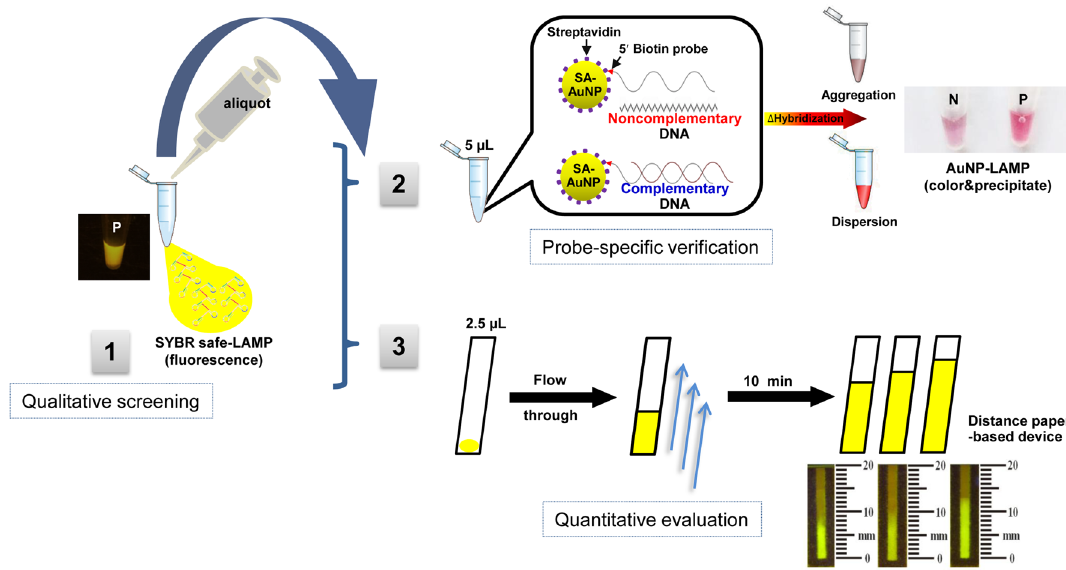
Figure 1. Schematic procedure of LAMP detection and semi-quantification using a distance-based paper device combined with one-step SYBR safe and gold-nanoparticle probe LAMP limit the boundary channel of sample and detection zones of the dPAD, the filter paper was dropped so that the LAMP reaction could flow into the detection channel zone without leakage of the flow samples. Five different patterns of dPAD were shown to immobilize the LAMP reaction at different lengths of migratory distance and could be directly measured by BL visualization. To acquire the suitable loading sample volume in the dPAD, the length difference of migratory distance between the negative and positive LAMP reactions at different parasites’ DNA concentration was evaluated. The optimization of each sample volume is shown in Fig. 2b. The samples were loaded at 0.5, 1.5 and 2.5 µL and the distance lengths of each load volume in millimeter scale (mm) were compared. The mean fluorescent distance of each concentration load volume was 1.78 ± 1.30 (mean ± SD) mm for negative control, 3.78 ± 2.11 mm for 10 5 parasites/mL and 5.11 ± 2.67 mm for 10 7 parasites/mL, respectively. The fluorescent distances were significantly differences in negative (N) and two positives (10 5 and 10 7 ) ( F = 25.85, 79.15, 130.85; P -value = 0.001, < 0.001, < 0.001, respectively). The differences of the fluorescent migratory dis- tance between positive and negative results at 0.5, 1.5 and 2.5 µL were 1.00, 2.00 and 3.00 mm with RSD values as 0.00 ( n = 3), 0.00 ( n = 3) and 0.00 ( n = 3), respectively for 10 5 parasites/mL, and 1.67, 3.34 and 5.00 mm with RSD values as 0.35 ( n = 3), 1.73 ( n = 3) and 0.20 ( n = 3), respectively for 10 7 parasites/mL. According to the difference of the flow results, the load volume at 2.5 µL demonstrated the longest immobilized length of fluorescent migra- tory distance on the filter paper as the best migratory distance. Of these, 2.5 µL which gained the highest fluo- rescent length of reaction flow distance were chosen as a standard load volume for all five patterns of the dPAD. All five patterns of the designed dPADs could differentiate between negative (N) and positive samples (10 5 and 10 7 ) (Fig. 3). The migratory distances were significantly differences in patterns 1 to 5 ( F = 7.84, 5.69, 11.44, 9.60, 30.41; P -value = 0.026, 0.048, 0.012, 0.017, < 0.001, respectively). The distances of Leishmania ’ DNA con- centration at 10 5 and 10 7 parasites/mL were similar to patterns 1 to 4. The differences ranged between 1.67 to 2.00 mm depending on the patterns of the devices (Fig. 3a). However, the highest difference at 3.67 mm was observed in pattern 5 between 10 5 and 10 7 parasites/mL (Fig. 3b) that constituted a simple straight pattern in which the LAMP reaction was loaded in the sample channel zone at the bottom of the device and flowed into the detection channel directly straight forward. Thus, pattern 5 was chosen to gain the optimal migratory distance. These were further used to calibrate a device using a linearity between the fluorescent distance and the standard concentrations of Leishmania ’ DNA, then for quantitative measurement of the LAMP products. Semi‑quantitative analysis and specificity. curve and linear range (Fig. 4). The results of serial dilution showed concordance of detection between the visual inspection of fluorescent dPAD (Fig. 4a) and colorimetric precipitate AuNPs probe, as well as gel electrophoresis (Fig. 4b). Gel electrophoresis exhibited various multiple bands of stem-loop DNA structures inferring success- ful amplification of LAMP products. The distance values of fluorescent migratory obtained from the dPAD at each concentration were plotted for observing the calibration curve and linear range. A calibration of the device showed a linearity between the fluorescent migration distance and Leishmania ’s LAMP amplicons in the range of 10 3 to 10 6 parasites/mL with a linear equation as y = 1.132x + 4.439 and R 2 as 0.997 (Fig. 4a). Using visual inspection of fluorescent dPAD and colorimetric precipitate AuNPs probe, cross amplifications were not detected except T. evansi when non Leishmania pathogens’ DNA was tested against the LAMP primers and probe. Obviously, differences in the fluorescent migratory distance were found in the LAMP positive reac- tion (11.7–12.7 mm) as compared with those of the negative control or reaction mixtures of non Leishmania